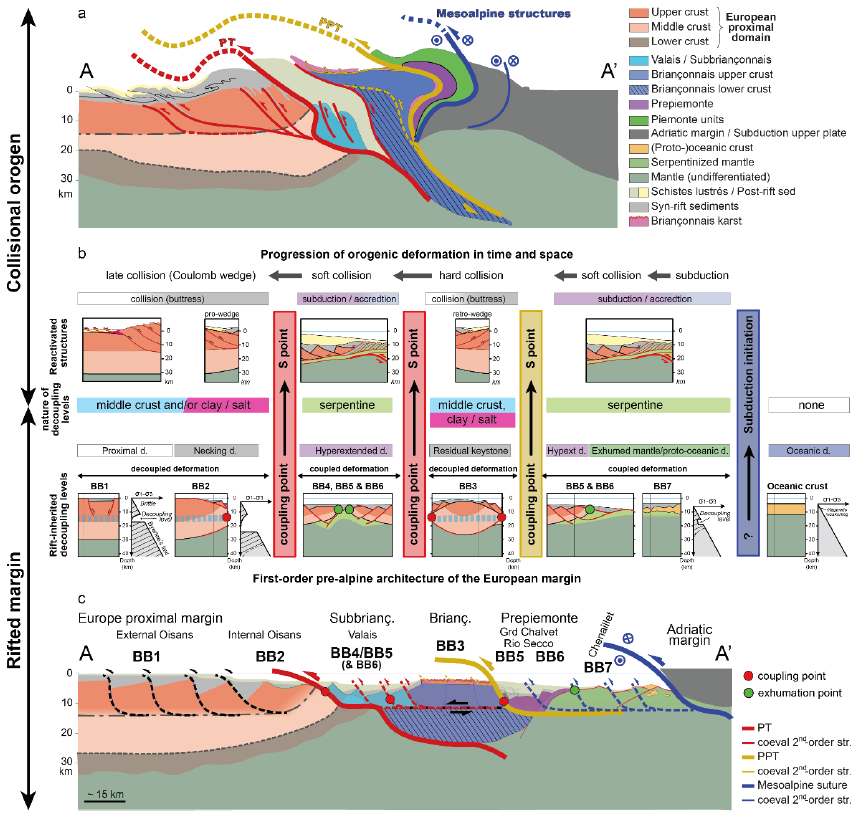
Figure 11. ( a ) Interpretation of the ECORS-CROP seismic profile (modified from [24]) showing the location of the main Alpine units described in the text (see Figure 12 for present and paleogeo- graphic location); ( b ) Conceptual model (modified from [12]) illustrating (top panel): the in-se- quence reactivation of coupling points and rift-inherited decoupling levels from subduction to soft